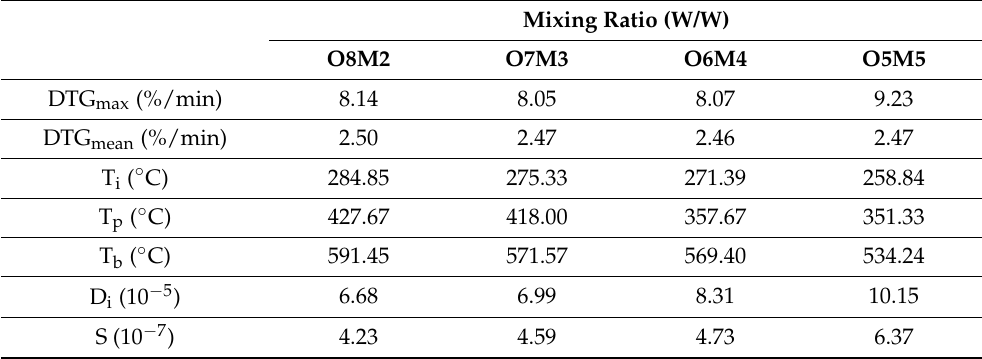
Table 3. Combustion property of RDF produced by oily sludge and waste mushroom